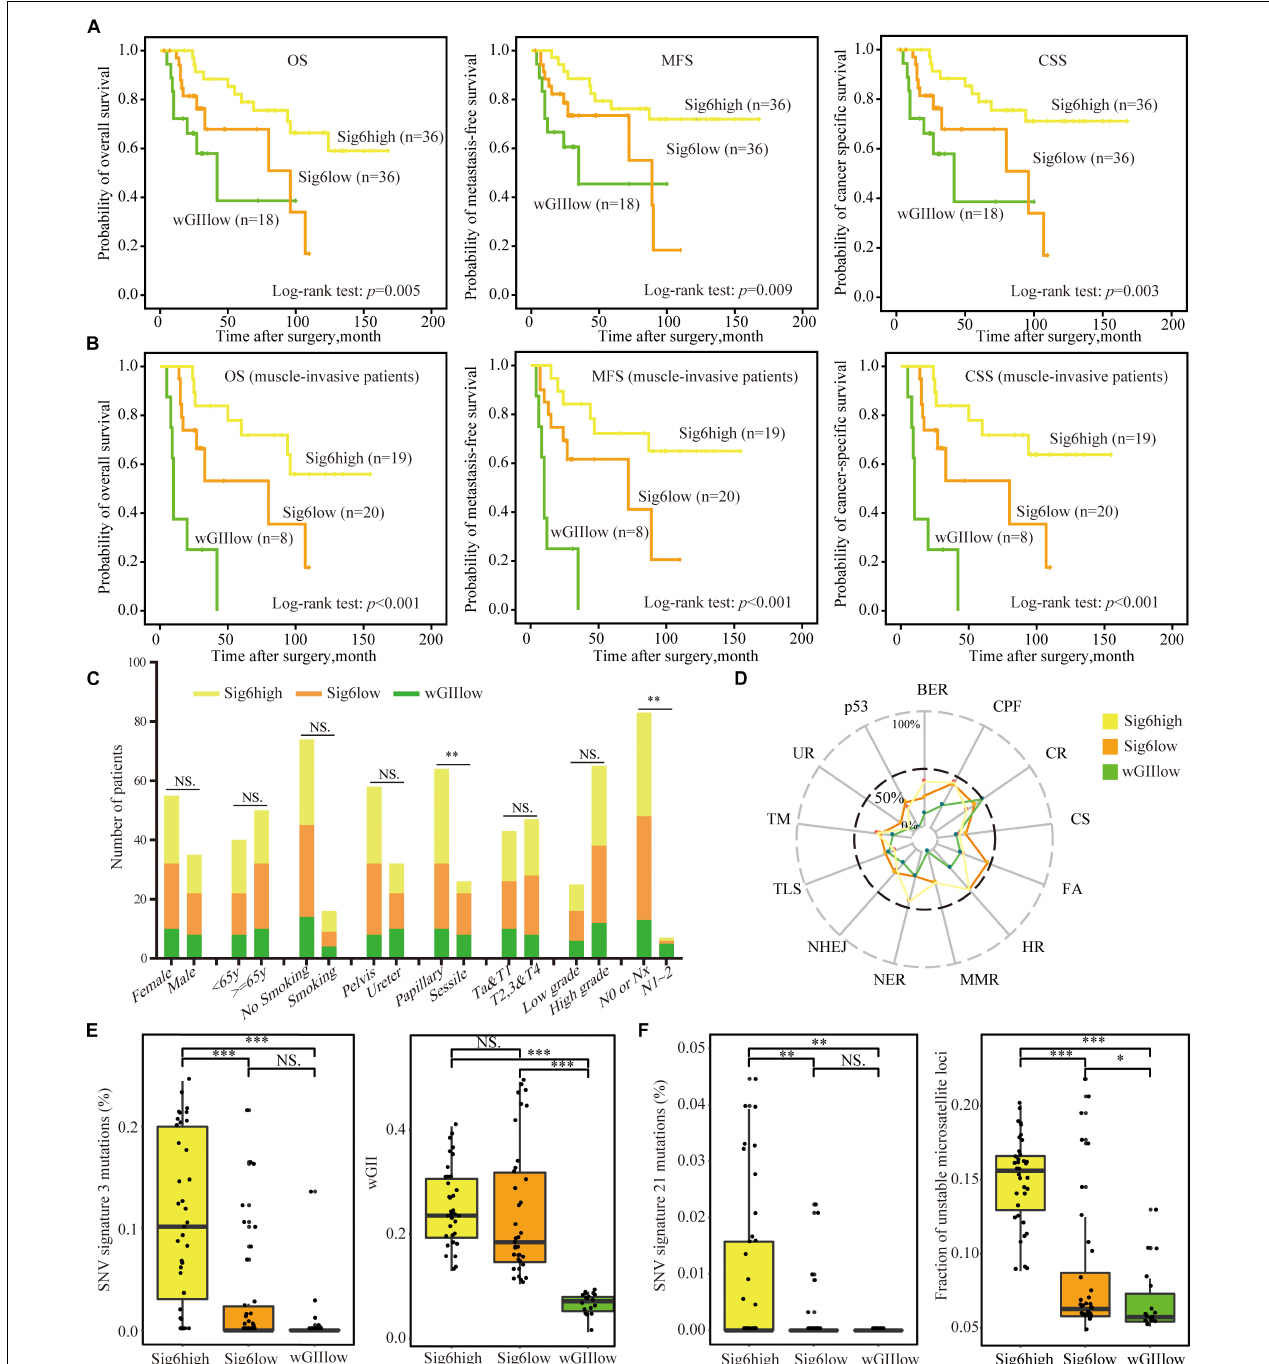
FIGURE 3 | The association of copy number CN signature and clinical features. (A,B) The Kaplan–Meier analysis of overall survival, metastasis-free survival, and cancer-specific survival in Cohort I (A) and in muscle-invasive tumor patients (B) . Statistical significance was determined by log-rank test. (C) The bar graph shows the association between the three CN signature subgroups and clinicopathological features. Statistical significance was determined by Kruskal–Wallis test, ∗∗ p < 0.01; and NS indicates not significant. (D) The proportion of samples mutated in DNA damage repair pathways of the three CN signature subgroups. (E) CN Sig6high subgroup patients had higher number of SNV signature 3 mutations and higher level of wGII than had wGIIlow subgroup patients. Statistical significance was determined by Wilcoxon rank test, ∗∗∗ p < 0.001; NS indicates not significant. (F) Patients with Sig6high subgroup had higher number of SNV signature 21 mutations and higher level of MSI than had wGIIlow subgroup patients. Statistical significance was determined by Wilcoxon rank test, ∗ p < 0.05, ∗∗ p < 0.01, ∗∗∗ p < 0.001; and NS represents not significant. CN, copy number; wGII, weighted genome integrity index score; MSI, microsatellite instability; WGS,